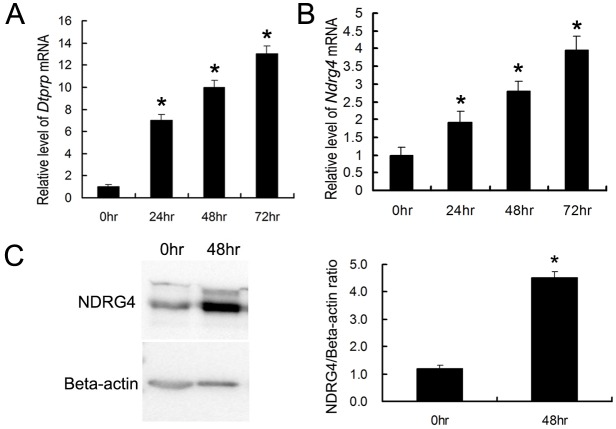
In vitro decidualization of mouse primary ESCs.(A) qRT-PCR analysis of DTPRP mRNA expression in ESCs cultured for up to 72 h. (B) qRT-PCR analysis of NDRG4 mRNA expression in cultured ESCs. (C) Western blot analysis of NDRG4 protein expression in ESCs cultured for up to 48 h. Densitometric analyses of NDRG4 compared with 0 h is shown. The values represent the mean ± SEM, as determined from three separate experiments. *, significantly different (P < 0.05).